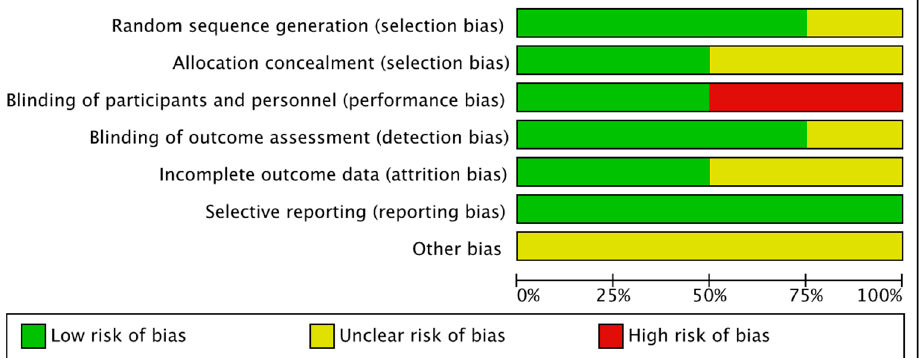
Figure 2. Risk of bias graph. Review authors’ judgements about each risk of bias item presented as percentages across all included studies.